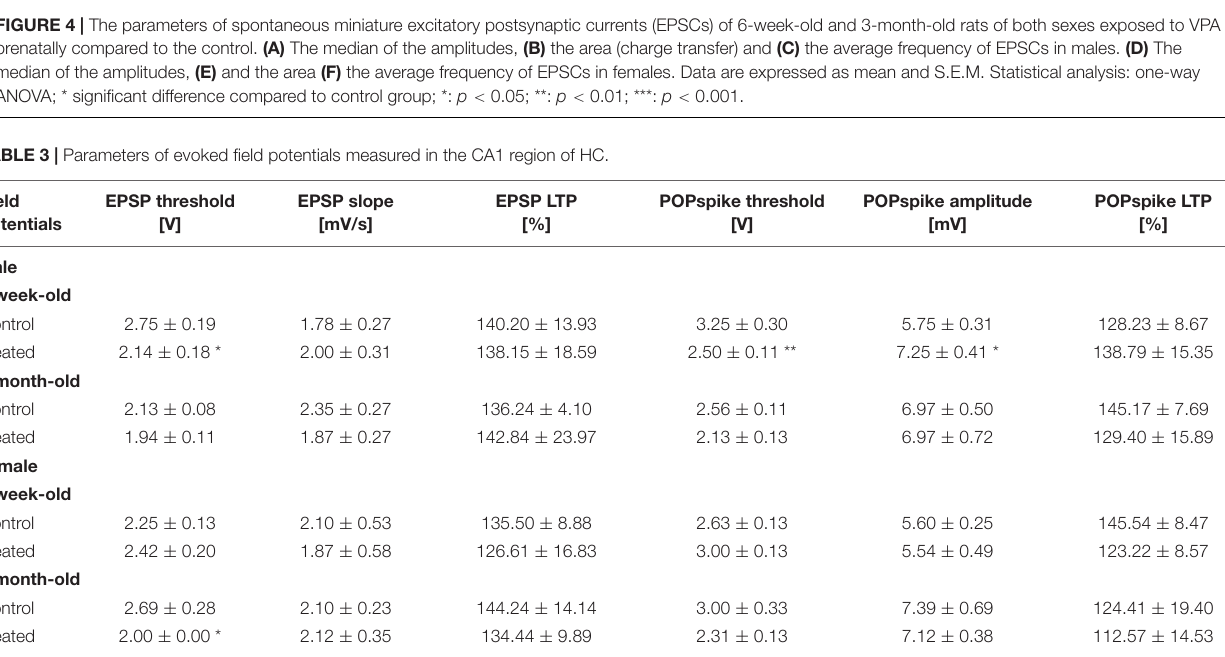
Data are shown as averages with standard errors. N = 6, 6, 8, and 8 in case of males and N = 8, 6, 8, and 8 in case of females in the 6-week-old control and treated and 3-month-old control and treated groups, respectively. Statistical analysis: one-way ANOVA; * means significant difference between the control and treated groups in the same age and sex; *p < 0.05; **p <